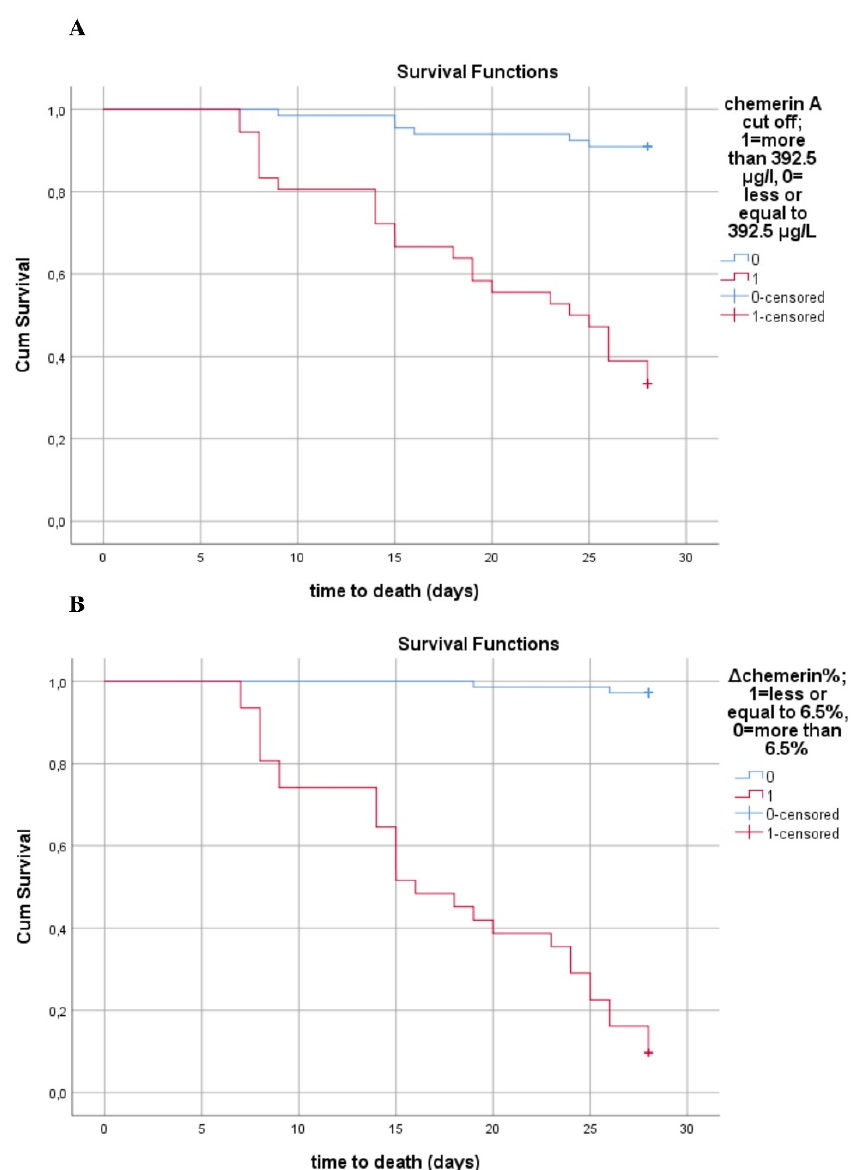
Figure 6. Kaplan–Meier estimates of mortality in 102 septic patients ( A ) Kaplan–Meier estimates of mortality based on serum chemerin at enrollment cutoff values obtained via ROC analysis (log rank test: 42.15, p < 0.001). ( B ) Kaplan–Meier estimates of mortality based on absolute percentage change of serum chemerin from baseline cutoff values obtained via ROC analysis (log rank test: 111.4, p < 0.001). Table 4. Multivariate Cox regression analyses results for the independent laboratory predictors of mortality (expressed as quartiles) adjusting for APACHE II score in 102 septic patients.